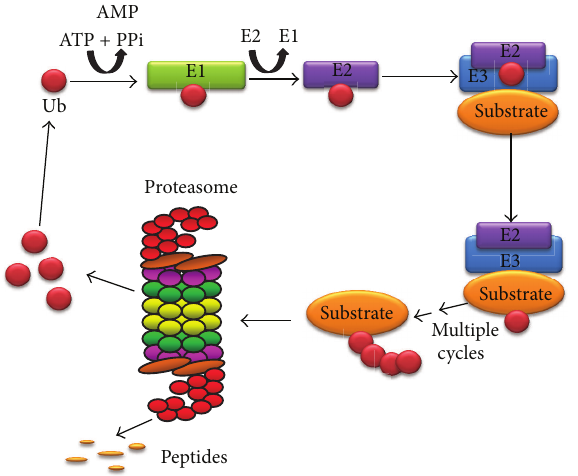
Figure 1: Schematic diagram of the ubiquitin-proteasome system. TheUPSinvolvesatleastthreeenzymes(E1,E2,andE3)thatcatalyze the addition of ubiquitin to lysine residues on the substrate protein. Polyubiquitinated substrates are then recognized by the proteasome or proteasome associating protein, and the ubiquitin removed by deubiquitinases and the substrate unfolded and translocated in the 20S core for